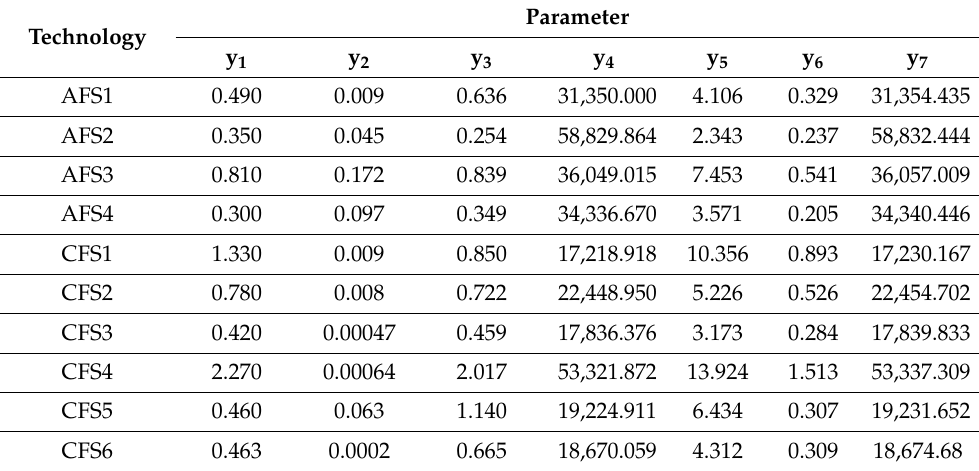
Table 7. Values of process parameters for the barns under study, including labor inputs, electrical energy consumption, and cumulative energy intensity per feeding practice.